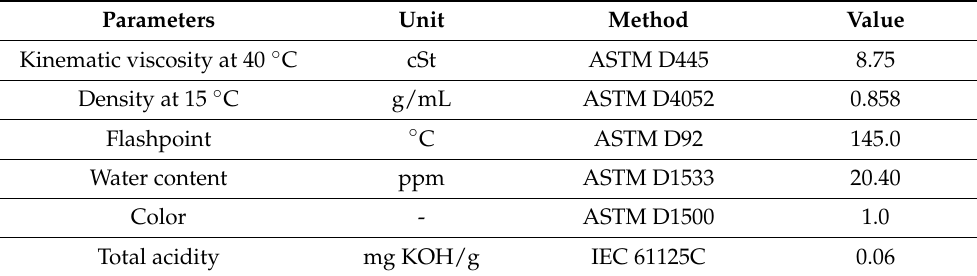
Table 6. Results of the oil sample